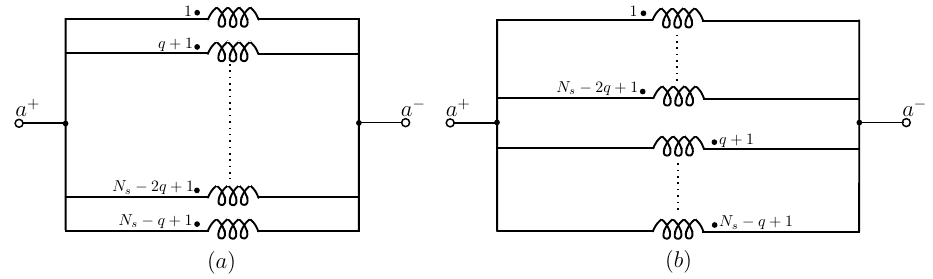
Figure 3. Connection of the coils of a phase: ( a ) the case of Figure 1, ( b ) the case of Figure 2. The case where the phasors of the back-EMFs induced in the coils of a given phase are colinearly equally distributed in the two opposite sectors is useless for multi-phase of phases q , such that